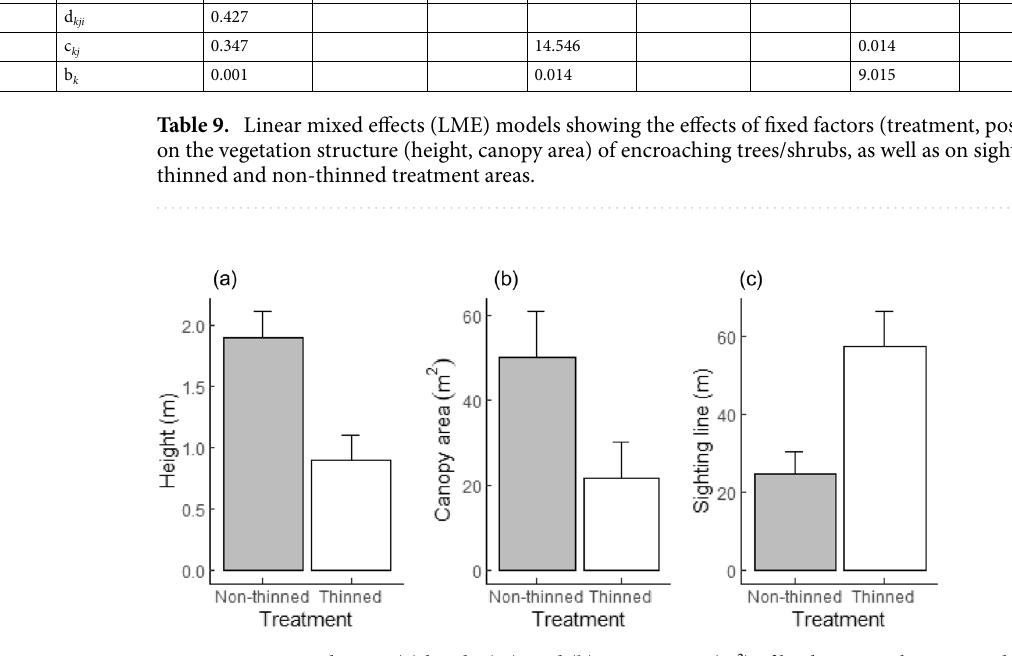
Figure 5. Expected mean ( a ) height (m), and ( b ) canopy area (m 2 ) of bush-encroaching trees/shrubs, as well as ( c ) sighting lines (m) in the thinned and non-thinned treatment areas estimated from the linear mixed effects (LME) model coefficients. Error bars indicate ± 95% confidence level of the variability in tree/shrub height, canopy area and sighting lines of the non-thinned and thinned